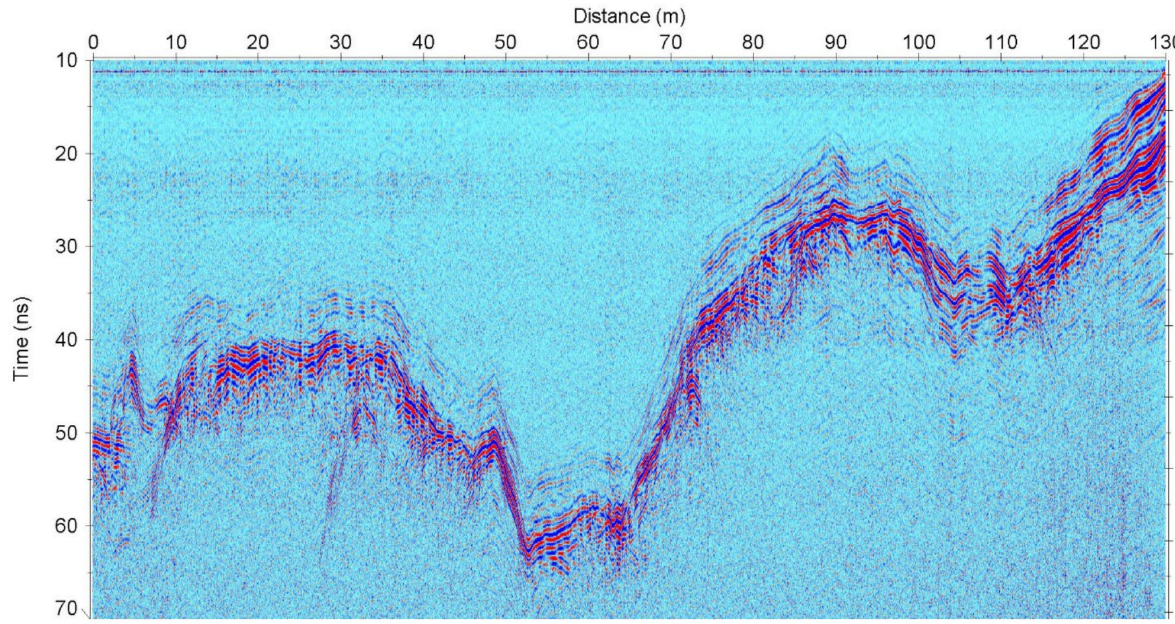
Figure 7. Example of GPR section acquired from the drone (line